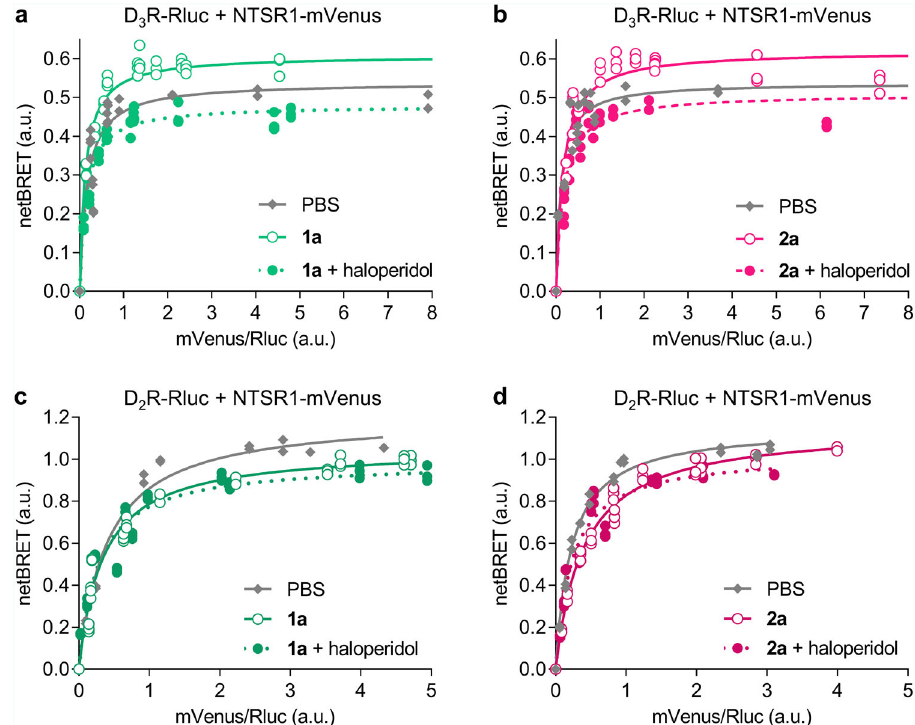
Fig. 4 Short-spacer bivalent ligands selectively act on D 3 R-NTSR1. a , b Bivalent ligands with a 22-atom spacer ( 1a , 2a ) increase BRET max between D 3 R-Rluc and NTSR1-mVenus, but not D 2 R-Rluc and NTSR1-mVenus ( c , d ). Preincubation with haloperidol (10 µ M, 30 min) prevents the effect of the bivalent ligand, resulting in a decrease in BRET max comparable to incubation with NT(8-13) alone. Data show individual replicates for a single representative experiment of at least three independent repetitions. COMMUNICATIONS BIOLOGY| (2021) 4:1062 |https://doi.org/10.1038/s42003-021-02574-4|www.nature.com/commsbio